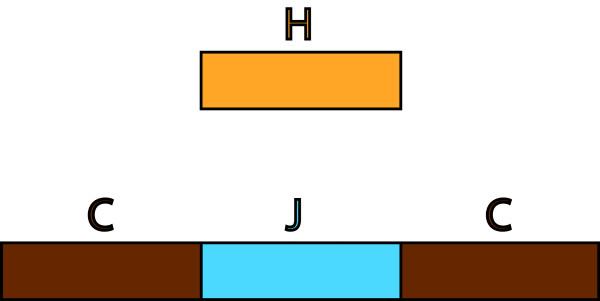
Example sequences of the test data. Sequences of the test dat sets Tpure (upper) and Trec (lower) are shown.